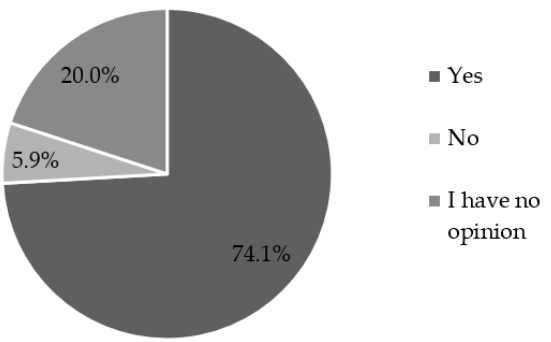
Figure 2. Nurses’ opinion on whether individual documented pharmacist’s advice should be fully reimbursed by the National Health Fund or other insurance institution (n = 85).